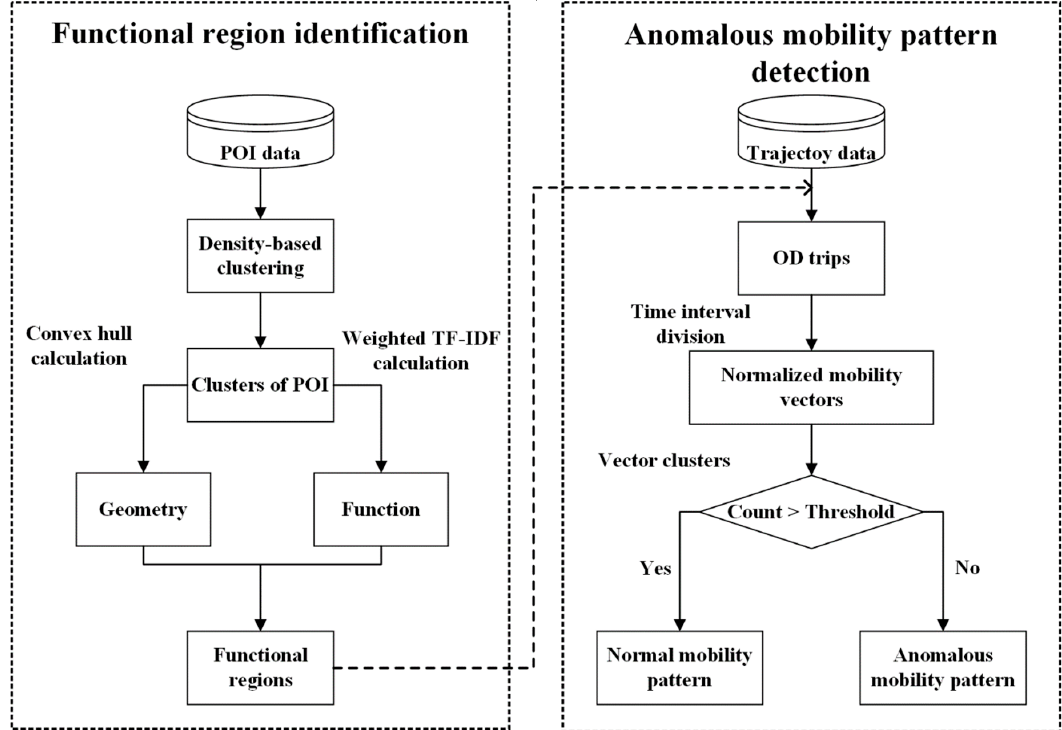
Figure 1. Framework of anomalous mobility pattern detection.